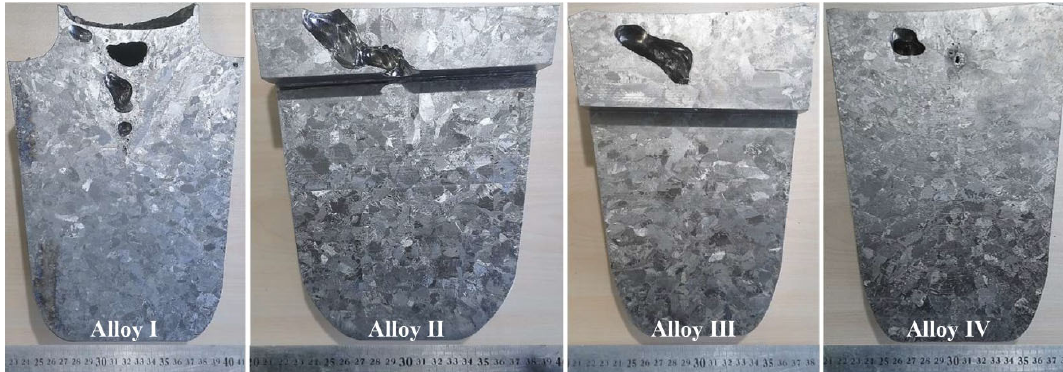
Metals 2022 , 12 , 2122 Figure 10. Macrostructure of Ti ‐ 6Al ‐ 4V alloy ingots. Figure 10. Macrostructure of Ti-6Al-4V alloy ingots.